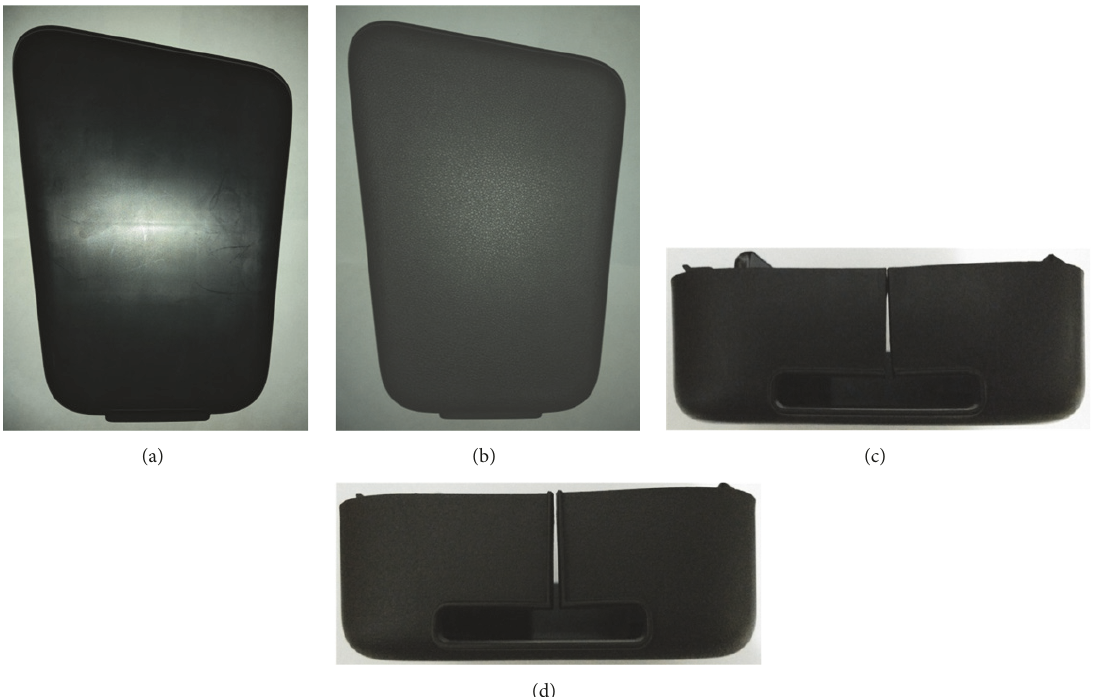
Figure 14: Comparison of the cover plate before and after optimization: (a) surface sink marks before optimization, (b) surface sink marks after optimization, (c) warpage before optimization, and (d) warpage after optimization.